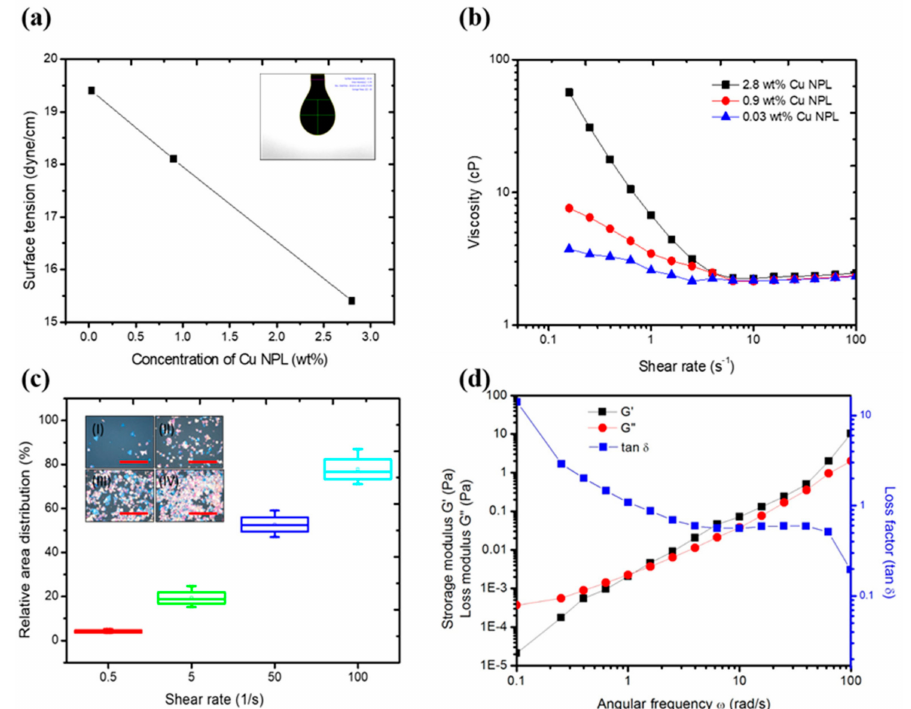
Figure 2. Rheological behavior tests for Cu NPL solution. ( a ) Surface tension vs. di ff erent concentration of Cu NPL solution (inset image shows a surface tension of the Cu NPL solution with 17 dyne / cm). ( b ) Steady state test for Cu NPL solution with 0.03, 0.9 and 2.8 wt% concentration. ( c ) Shear thinning e ff ect on relative area distribution according to shear rate, and the insets show images of the coated Cu NPLs on PET with shear rates of 0.5 (I), 5 (II), 50 (III), and 100 (IV). ( d ) Frequency sweep test for 2.8 wt% Cu NPL solution showing loss factor of 2.89.